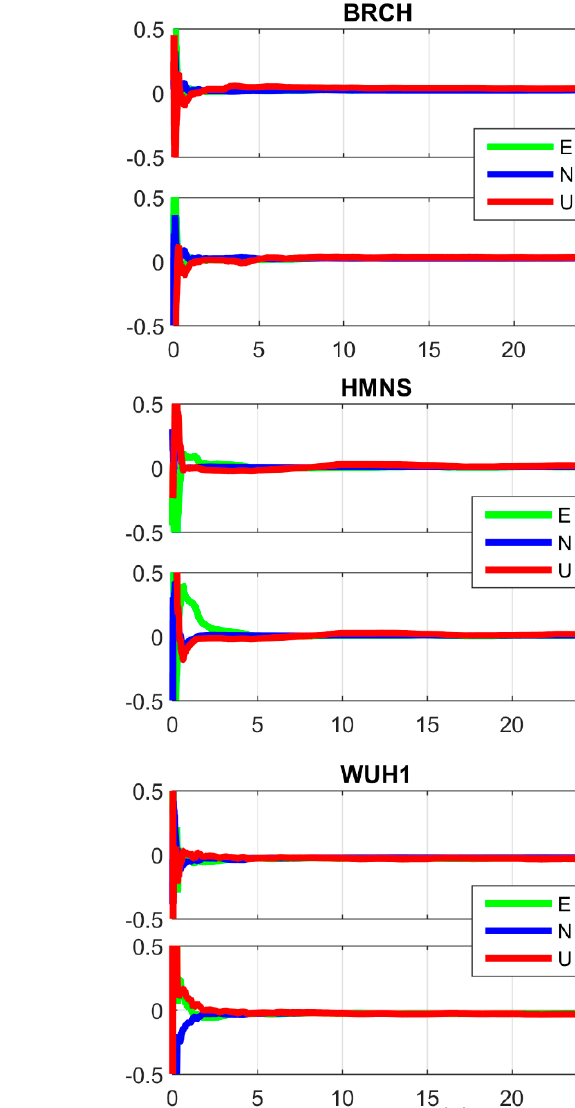
Figure 21. Positioning errors of B1I/B3I PPP without DCB correction at six stations.